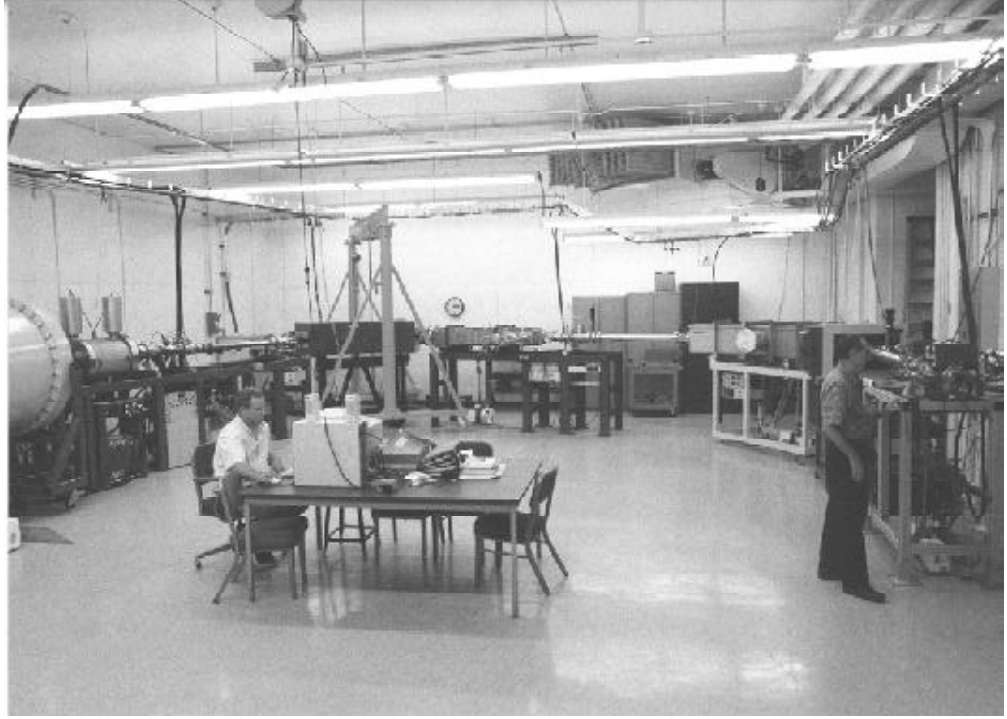
FIGURE 2. The high-energy section of the 3MV Pelletron AMS at the University of Arizona. Part of the accelerator is shown on the left, and an electrostatic deflector, the analyzing magnet is also shown on the left. On the right, the 77º electrostatic analyzer and detector system are shown next to Prof. D. Donahue. Mr. D. Biddulph is shown on the computer in the center of the